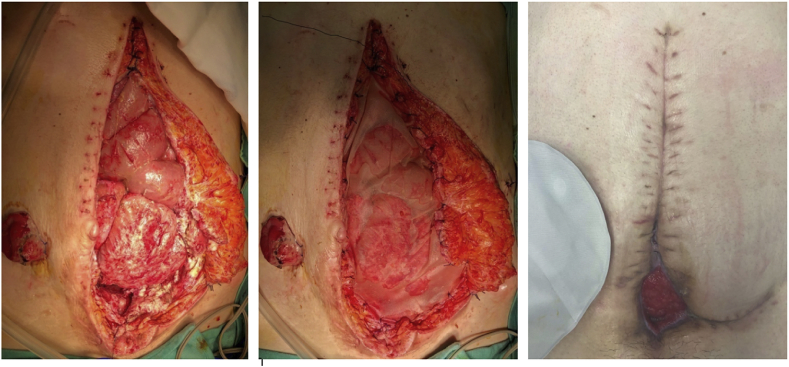
Abdominal wall during surgery and at 6th post-operative month.